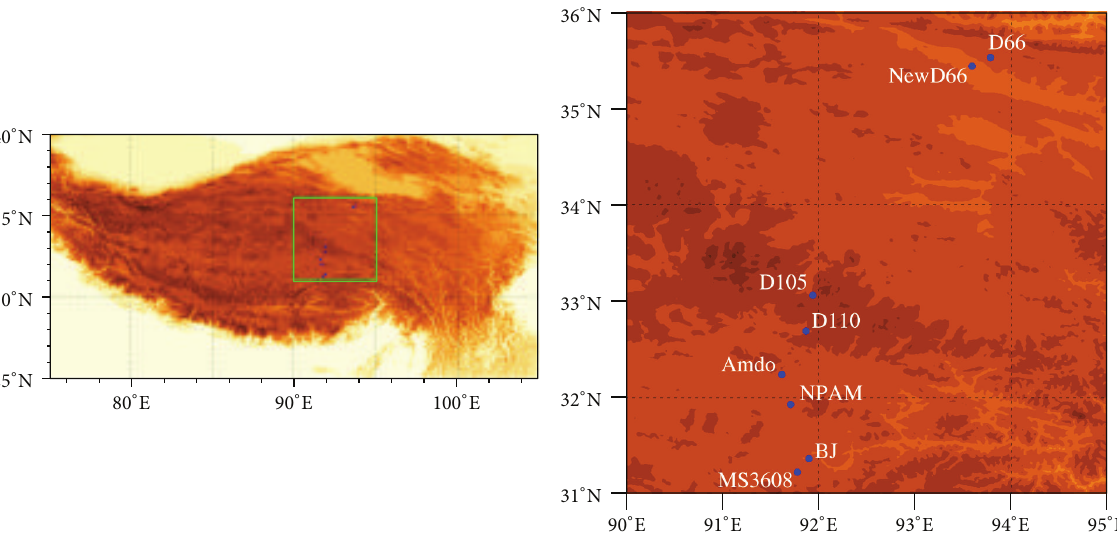
Figure 1: Map for the observation area and locations of stations in the Northern Tibetan Plateau.